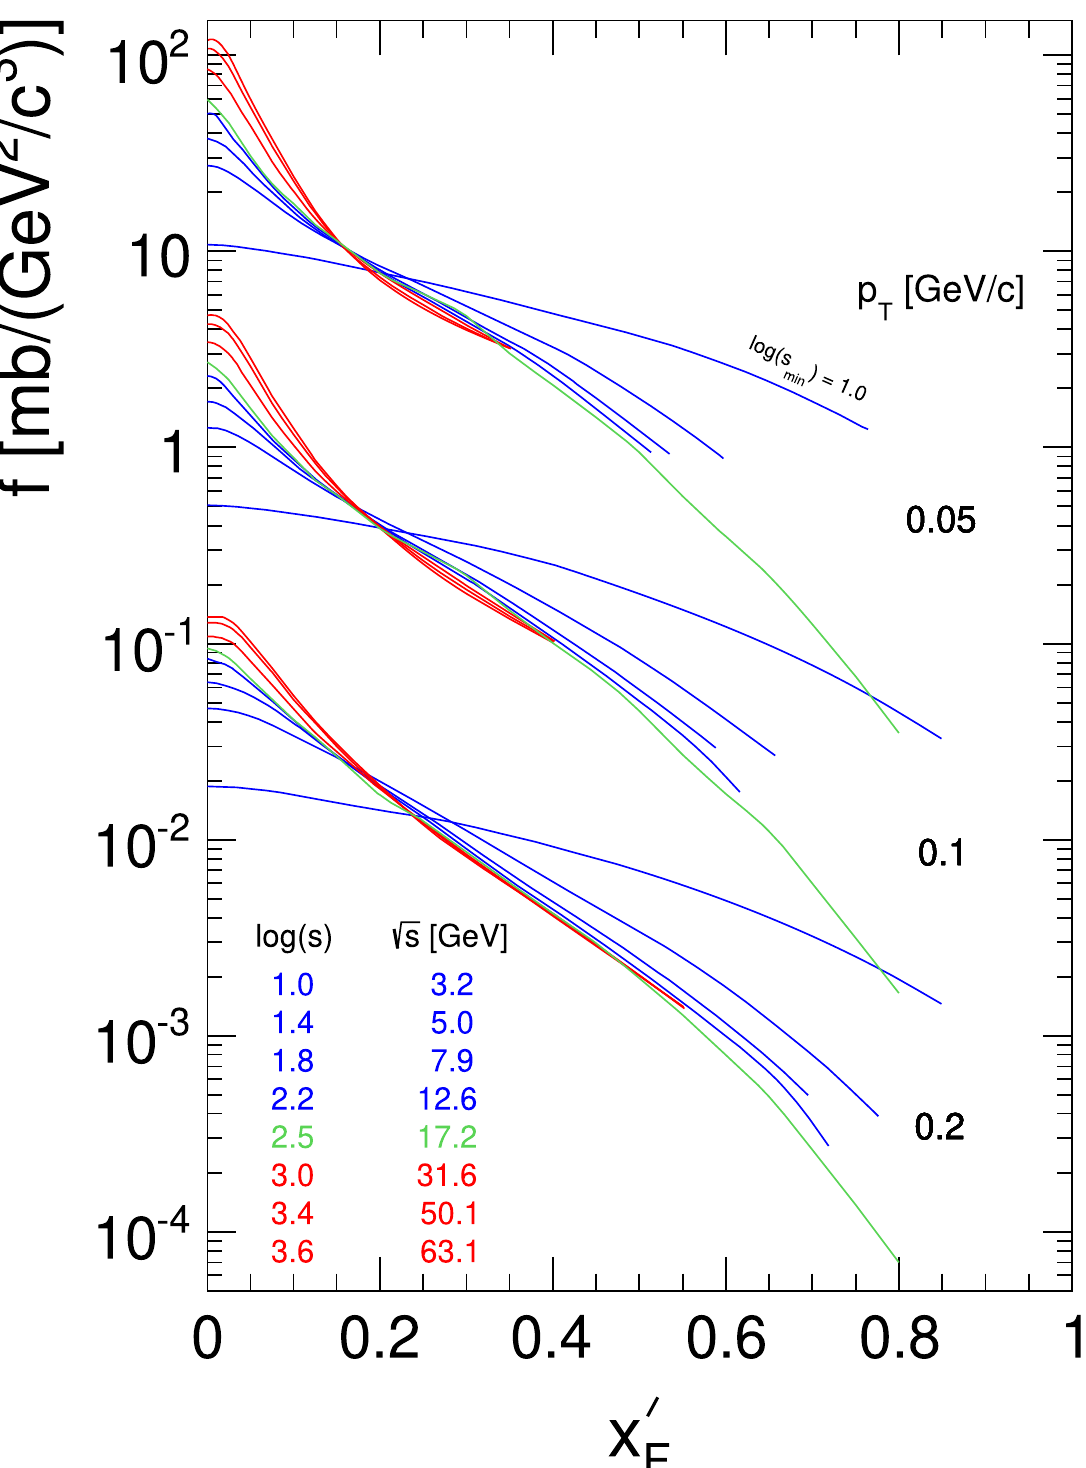
, p ) as a function of x (cid:3) Fig. 117 f ( x (cid:3) for p T = 0.05, 0.1 and 0.2 GeV/c for the global interpolation at log s values from 1.0 to 3.6. The plots at T F F subsequent p T values are scaled down by 1/20 for better separation. The NA49 interpolation at log ( s ) = 2.48 is shown as a green